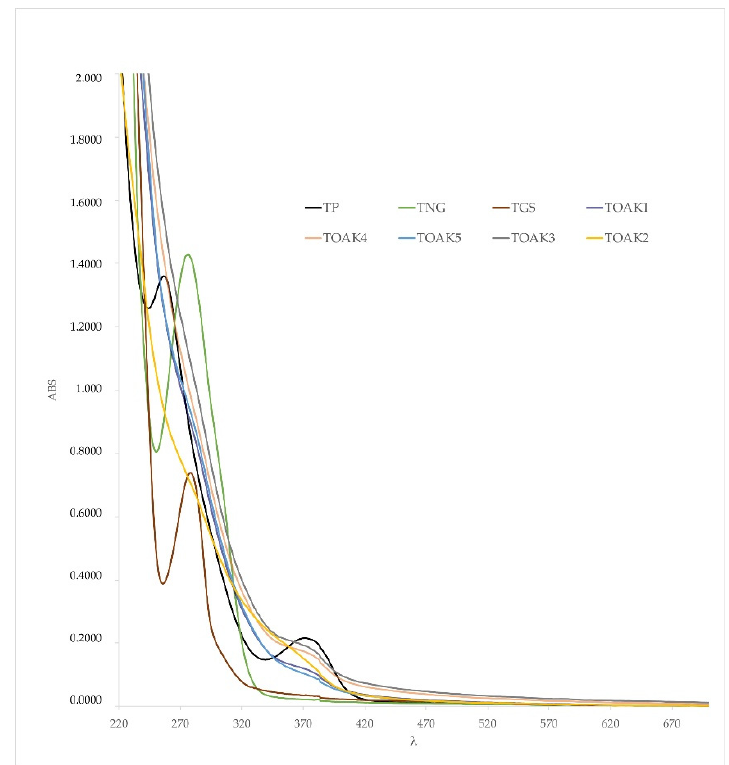
Figure 5. UV-Vis spectra of the analyzed tannins dissolved in the model wine solution. Pomegranate tannin; TGS, grape seed tannin; TNG, Nut gall tannin; TOAK1, TOAK2, TOAK3, TOAK4, TOAK5, Oak tannin 1–5, respectively.